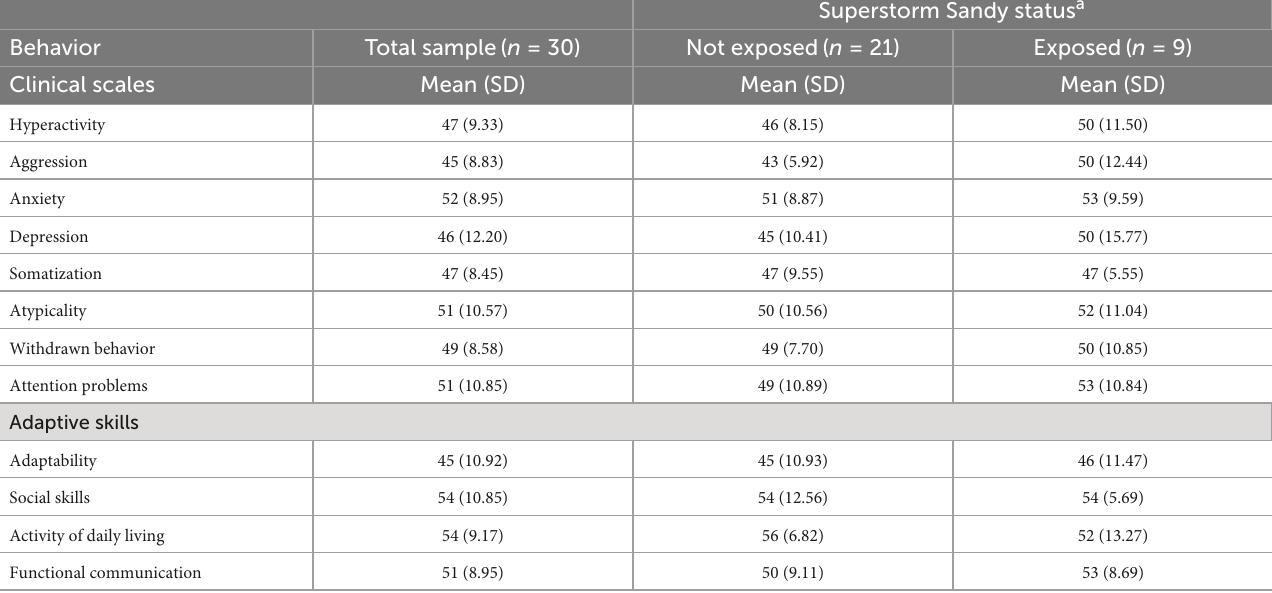
TABLE 1 Mean clinical and adaptive neurobehavioral scores by SS exposure.